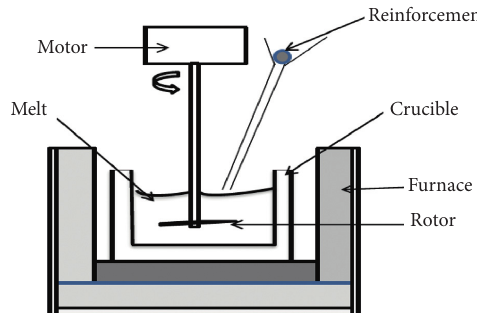
Figure 2: Stir casting technique for the fabrication MMCs.